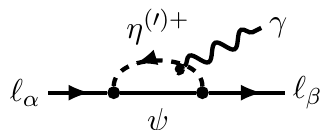
Figure 2 . Diagram contributing to ‘ (cid:11)